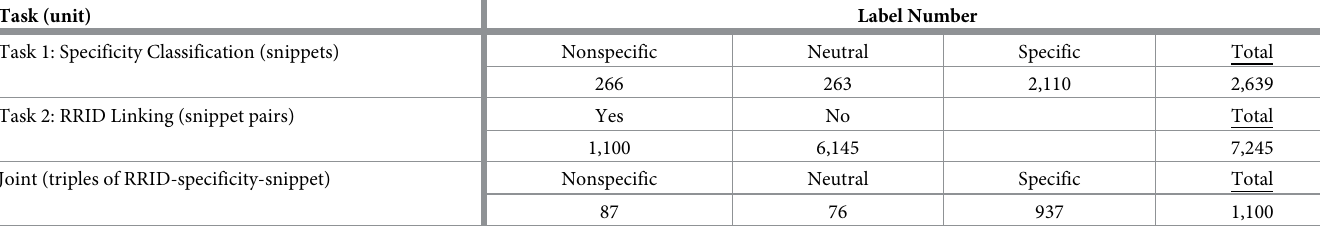
Table 2. Statistics of the annotated data. We annotated 2,639 snippets for specificity classification (Task 1) and 7,245 snippet pairs for RRID linking (Task 2). Among 7,245, 1,100 are linked. Their specificity class distribution is shown (Joint). Task